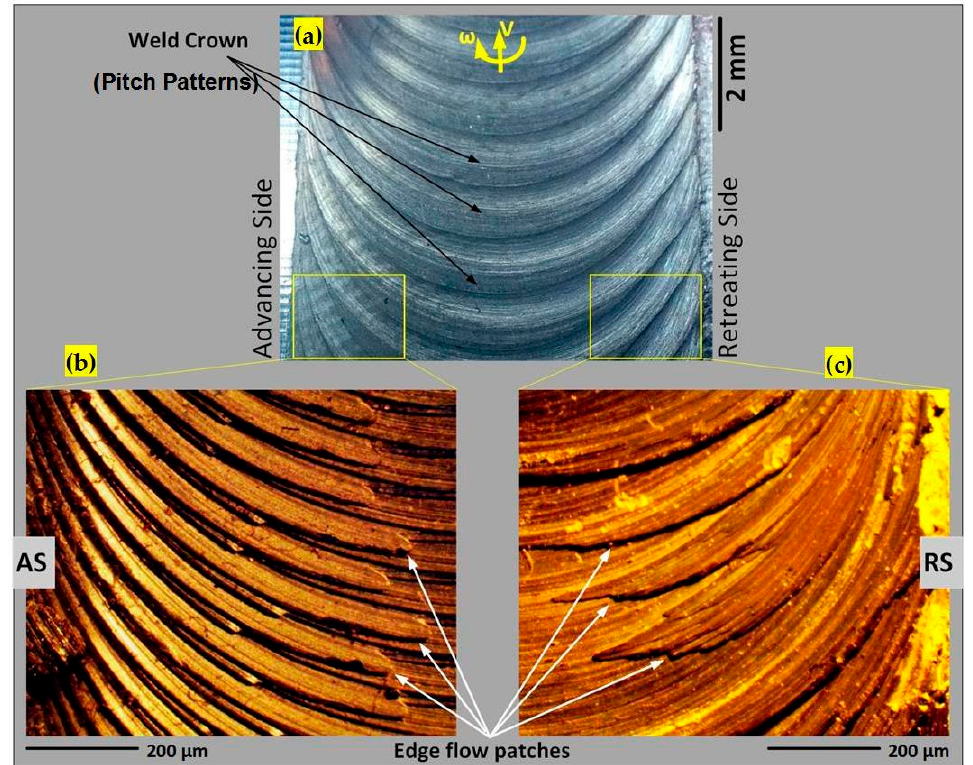
Figure 11. Surface flow patterns at the centre of the weld-line. ( a ) Plan view of the weld surface, ( b ) Macro-etched sub-shoulder (0.5 mm deep) flow patterns at the AS, and ( c ) Macro-etched sub-shoulder (0.5 mm deep) flow patterns at the RS.